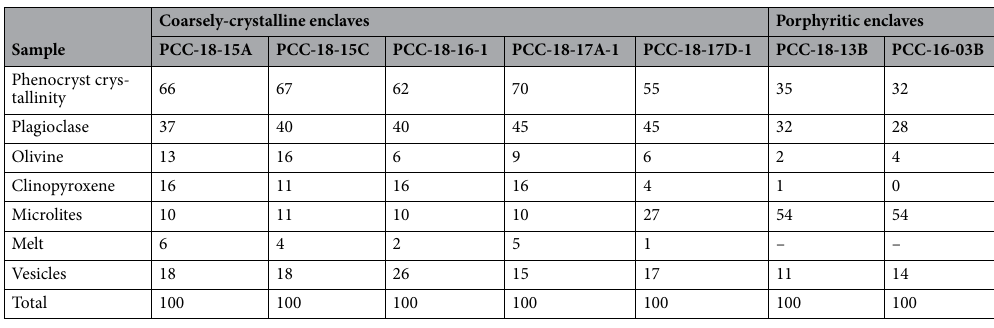
Table 1. Crystallinity of mineral phases, microlites, melt, and vesicles for both enclave populations. All values represent percentages (%).